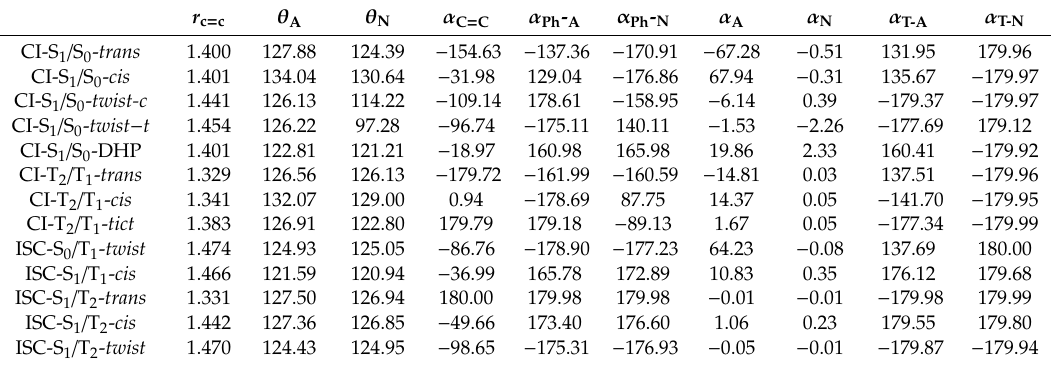
Table 2. The SA6 − CASSCF(18,12) / 6-31G* optimized internal coordinates for the conical intersections (CI) and intersystem crossings (ISC).